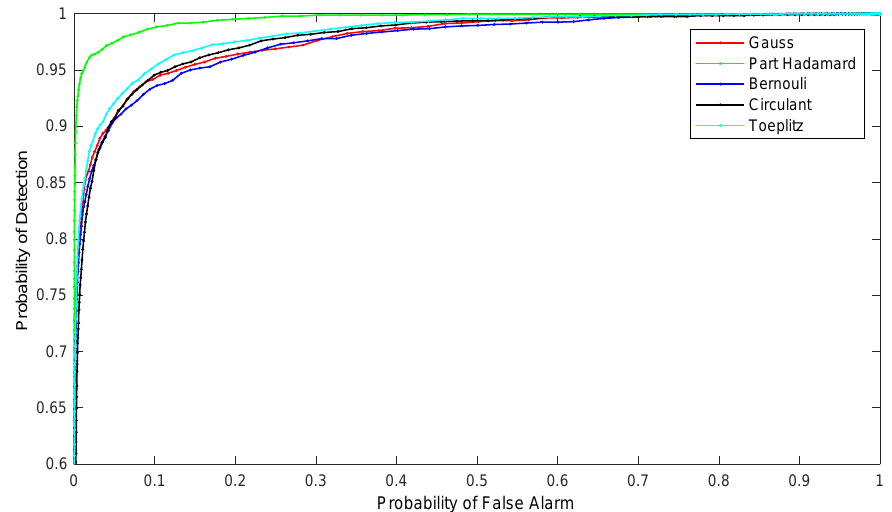
Figure 5. The average ROC curve of subtraction image mapping by different measurement matrixes: the measurement matrixes are Gauss matrix, Part Hadamard matrix, Bernouli matrix, Circulant matrix and Toeplitz matrix.